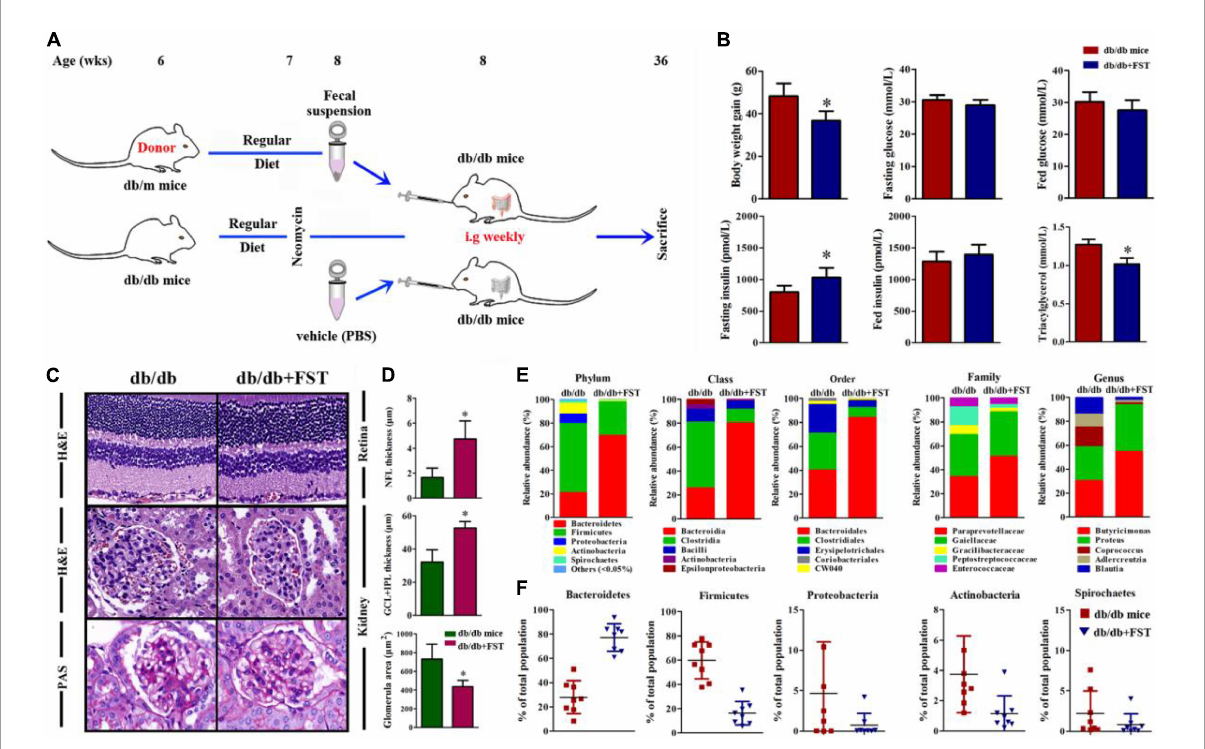
FIGURE5 Obesity exacerbated DR, DN, and inflammaging condition through gut microbiota. (A) Schematic representation of microbiotal transfer experiments where recipient mice (db/db) were gavaged with a suspension of fecal pellets in PBS from donor mice (db/m) or vehicle. The experimental timeline describing preparation of mice for microbiotal transfers where mice received 7 days of antibiotics (neomycin and ampicillin) at 6 weeks of age. Starting at 8 weeks of life, db/db mice received weekly microbiotal transplants from db/m donor mice until killing at week 36. (B) Body weight, blood glucose, insulin, and triacylglycerol levels after 16 h of fasting, and in the random fed state in mice with or without microbiotal transfers. n = 8 in per group. ∗ P < 0.05. (C) HE staining was performed to detect vessels morphological changes of retinal sections ( C , Upper), HE ( C , Middle) and PAS ( C , Bottom) staining was performed to detect glomerulus morphological changes of kidney sections. (D) Quantitation of the thickness of NFL( D , Upper), GCL + IPL ( D , Middle) and the glomerular area ( D , Bottom) in db/db mice with or without microbiotal transfers were followed. Error bars represent mean + S.D. n = 8 in per group. ∗ P < 0.05. (E,F) Representative charts of relative abundance of bacterial phyla, class, order, family (E) and genus in gut microbiota of db/db mice with or without microbiotal transfers, and relative proportion per group of different phyla (F) . n = 8 in per group. ∗ P <